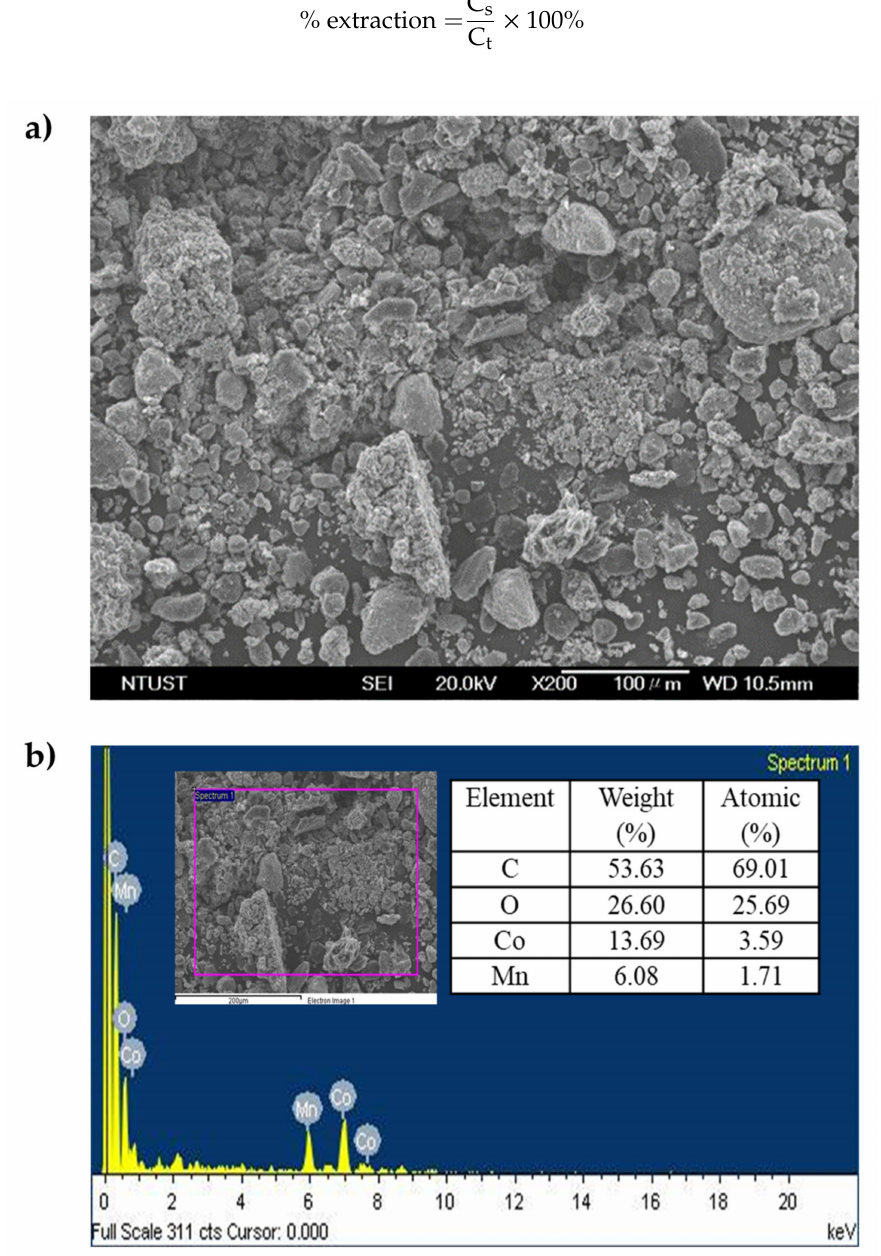
Figure 4. ( a ) FESEM image and ( b ) EDS result of cathode powder of spent